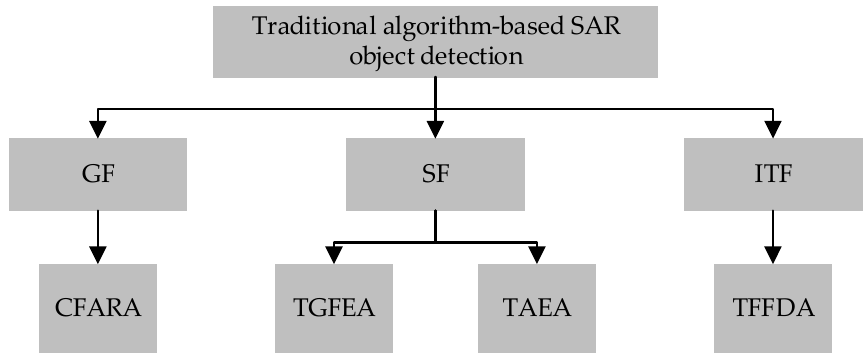
Figure 2. Classification of SAR image target detection based on traditional algorithms.